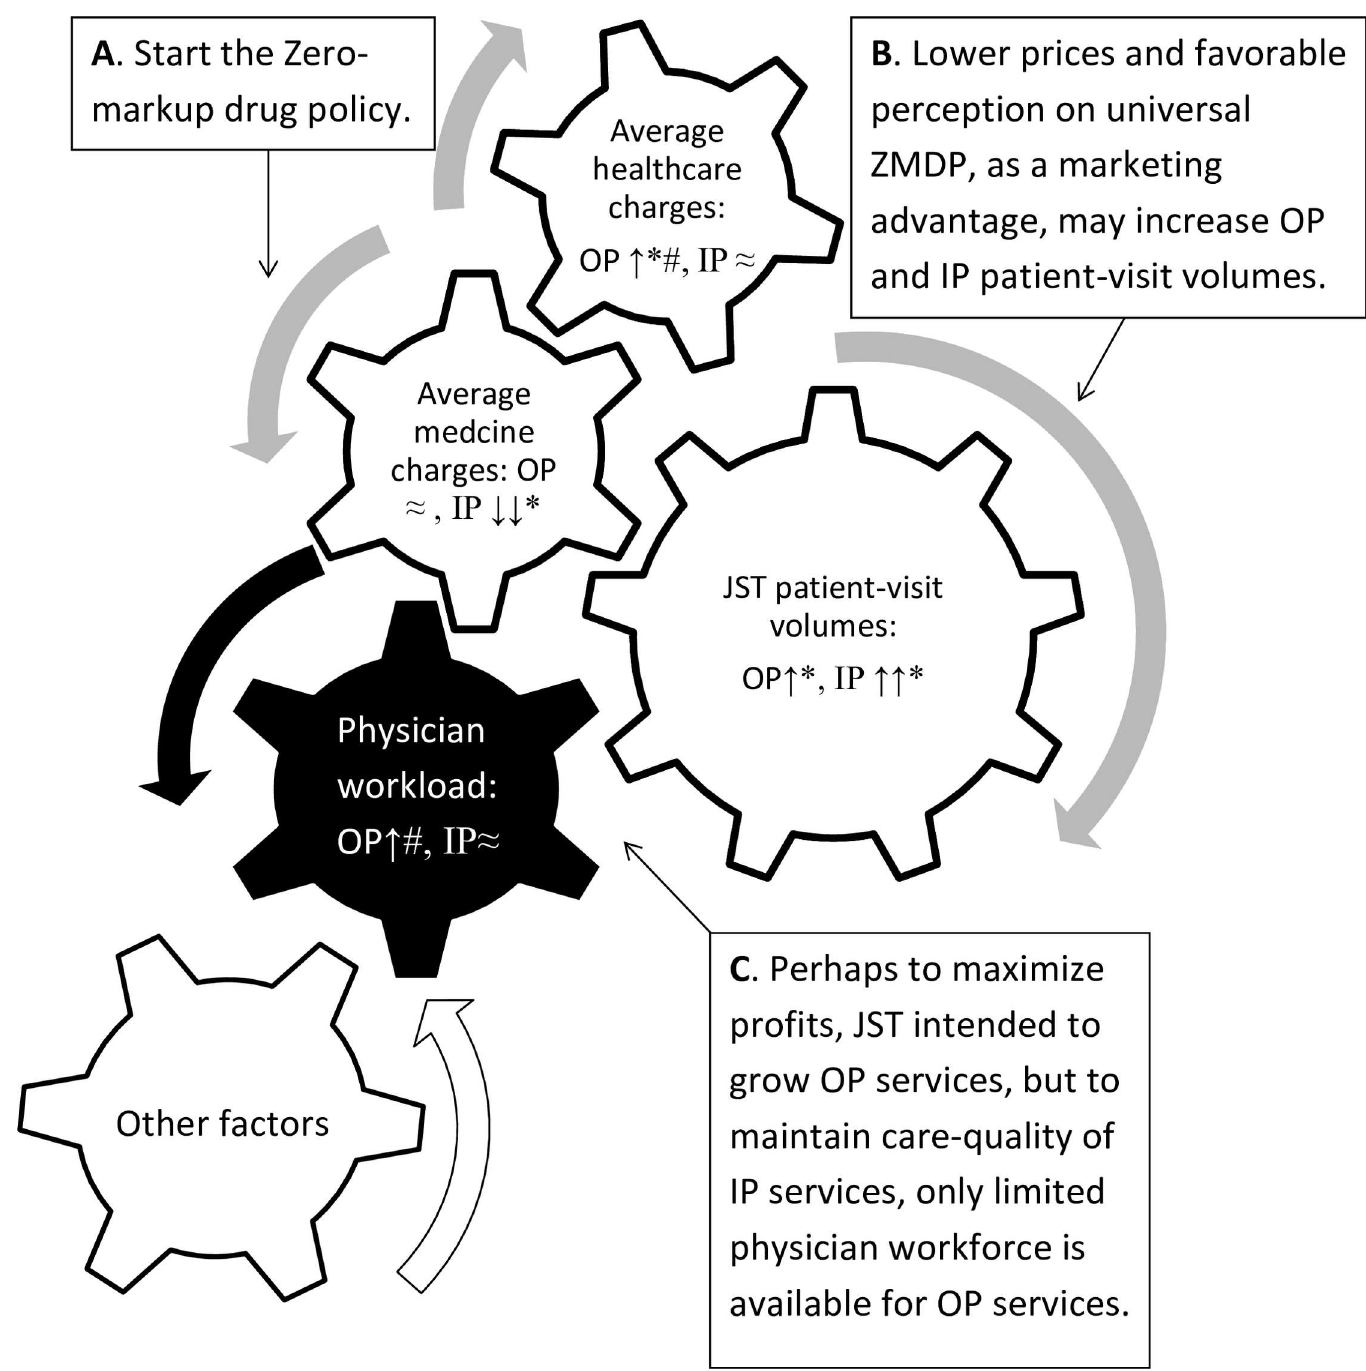
Fig 4. Theoretical framework. JST: JishuitanHospitalat Xinjiekou campus, Beijing,China;OP: Outpatient;IP: Inpatient; (cid:25) : No significanttrendsidentified; " : significantlyincreasedannual percentagechanges (increasingtrend); # : significantlydecreasedannual percentagechanges (decreasing trend); * significantdifference in trendsbetween Jishuitanhospitaland the tertiaryhospitalsin Beijing;# significant difference in trendsbetween outpatient and inpatientservicesof Jishuitanhospital.